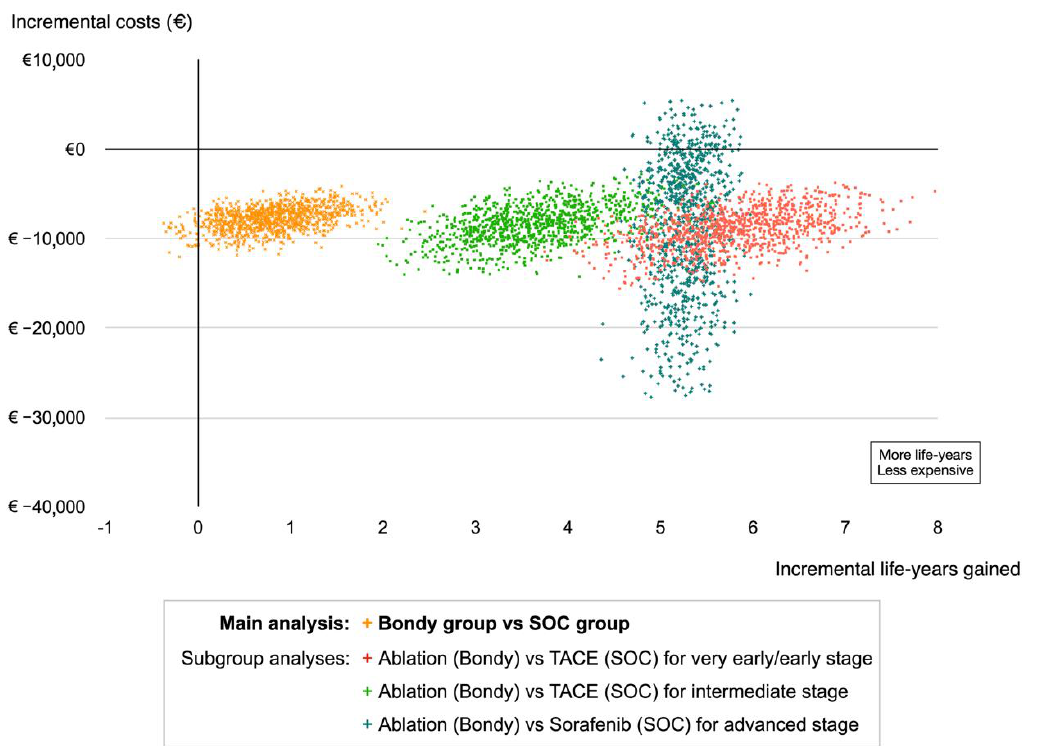
Figure 6. Scatter plot of the probabilistic sensitivity analysis from the matched cohort. The main analysis (Bondy group vs. SOC group) is depicted in orange. Subgroup analyses by BCLC stage are also presented. In the main analysis, 96.2% of the 1000 simulations were in the lower right quadrant (dominant strategy).